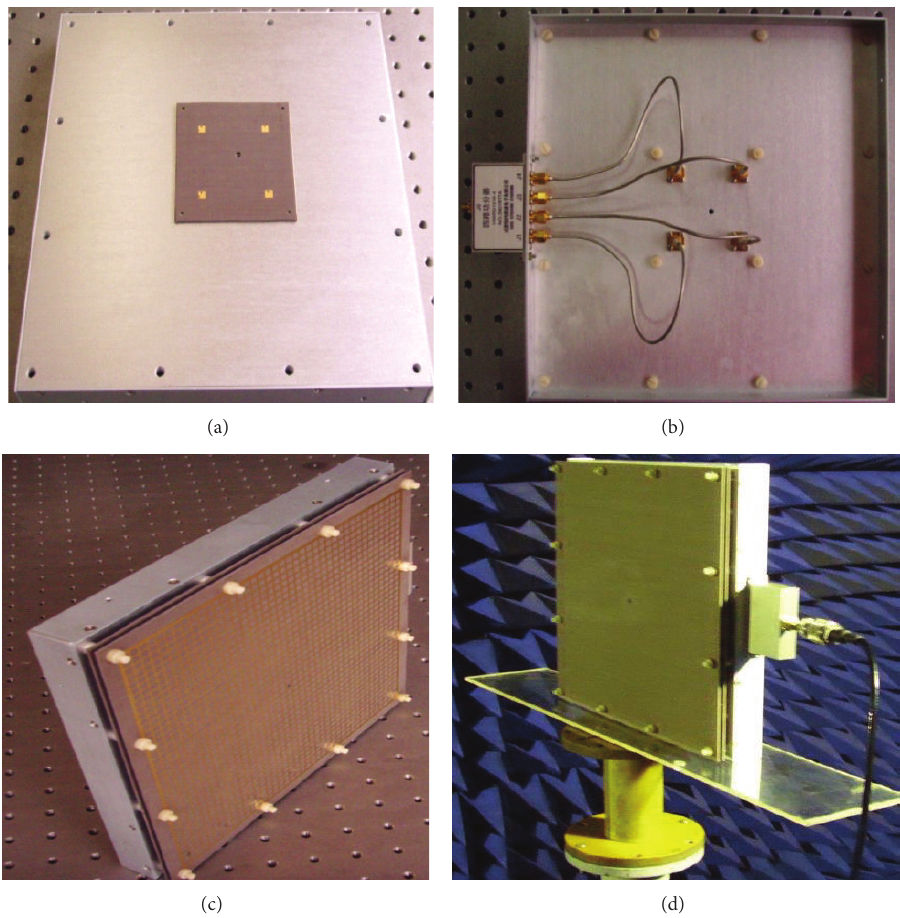
Figure 6: Photographs of patch antenna array and measured status in the anechoic chamber: (a) 2 × 2 element patch antenna array; (b) back view of the antenna array; (c) patch array with MTMs-cover; (d) MTMs-cover antenna in the anechoic chamber.